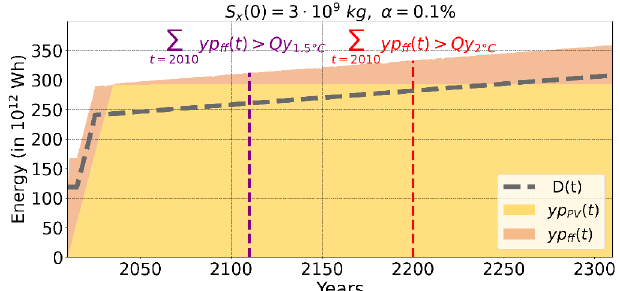
Fig. 9. Energy mix of France following the scenario C with t f = 400 years and S x (0) = 3 billion kilograms. Highlighting of delayed scarcity effect.